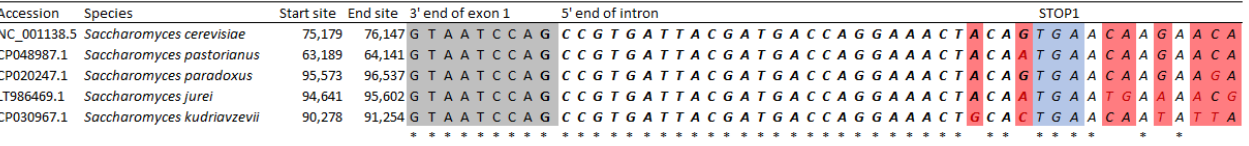
Figure 5. Local sequence alignments shows that the putative degron sequence is well conserved between Saccharomyces cerevisiae and four other closely related Saccharomyces yeasts. The start and end site respectively denote the start and end locations of the entire HAC1 gene in the yeast genomes. Shaded grey are the nine sites on the 3′ terminus of exon 1. Sequence in bold is the putative degron sequence in S. cerevisiae . Shaded in blue is the intronic STOP1 used by the truncated Hac1 u p. Shaded in red are non-conserved sites and the * at the bottom denotes fully conserved sites. Nucleotide sequences were aligned using MAFFT G-INS-i.